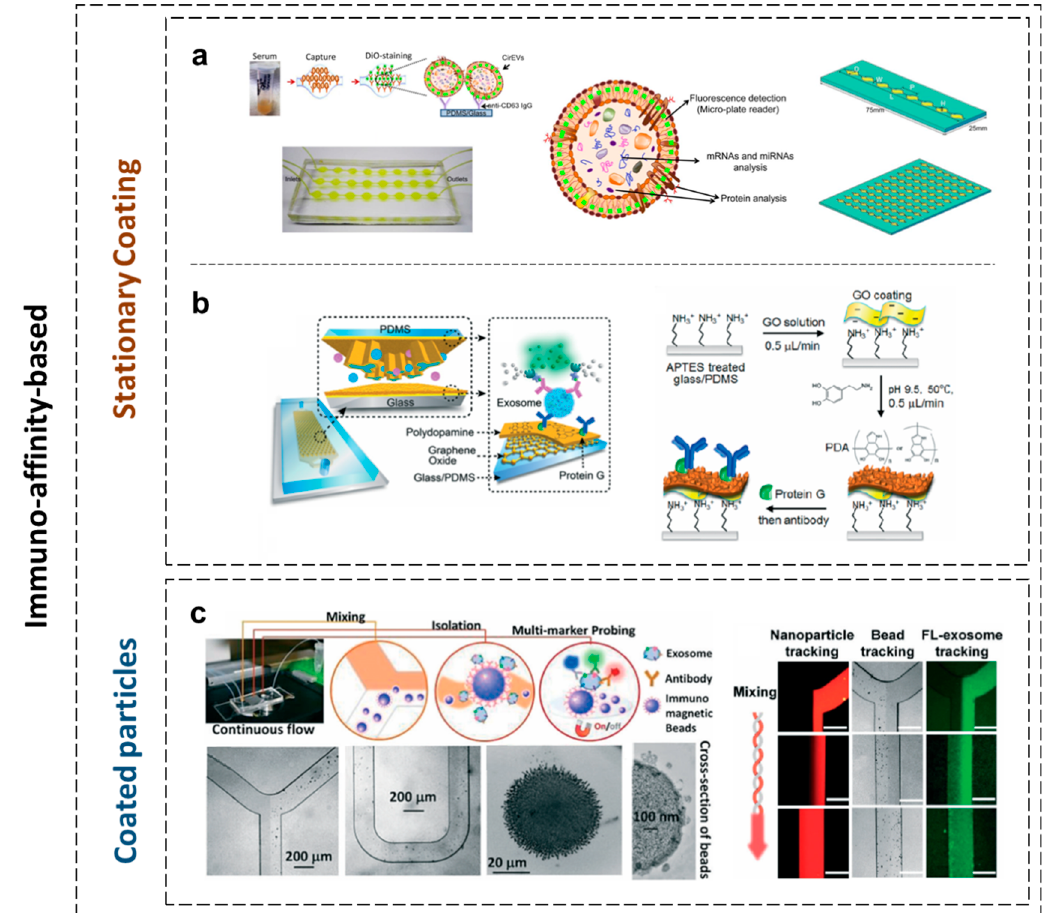
Figure 2. Immuno-affinity-based exosome separation. ( a ) The ExoChip and its operation procedure used for exosomes’ isolation and analysis, consisting of eight equally spaced circular chambers connected through a wide channel, allowing its use for analyzing multiple samples simultaneously. The polydimethylsiloxane (PDMS)-based working prototype ExoChip (with three channels) depicts the flow of serum for exosomes’ capture in a typical experimental setup [99], [reproduced with permission from [99], © 2014 Royal Society of Chemistry (RSC)]. ( b ) The nano-interfaced microfluidic exosome platform (Nano-IMEX). Schematic of a single-channel PDMS/glass device, with the exploded-view highlighting the coated PDMS chip containing an array of Y-shaped micro-posts. The surface of the channel and micro-posts are coated with graphene oxide and polydopamine as a nanostructured interface for the sandwich enzyme-linked immunosorbent assays (ELISA) of exosomes with enzymatic fluorescence signal amplification [100] (reproduced with permission from [100], © 2016 RSC). ( c ) The ExoSearch platform. A robust, continuous-flow platform providing the enriched preparation of blood plasma exosomes for in situ, multiplexed detection using immunomagnetic beads for the quantitative isolation and release of exosomes [101] (reproduced with permission from [101], © 2016 RSC).